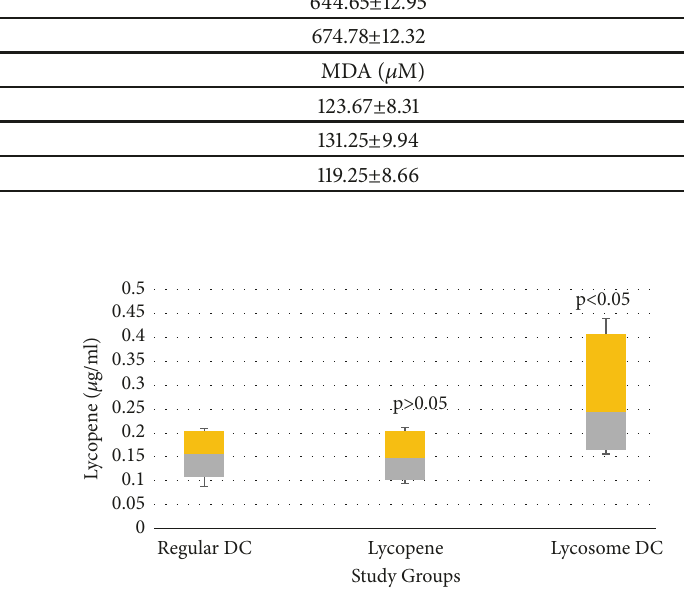
Figure4:Box-and-whiskeranalysis.Serumlycopenelevelafter3hoursfollowingingestionofL-tugDC(“ p ”valuereflectsstatisticaldifference in lycopene concentration among study groups as compared to regular DC group).